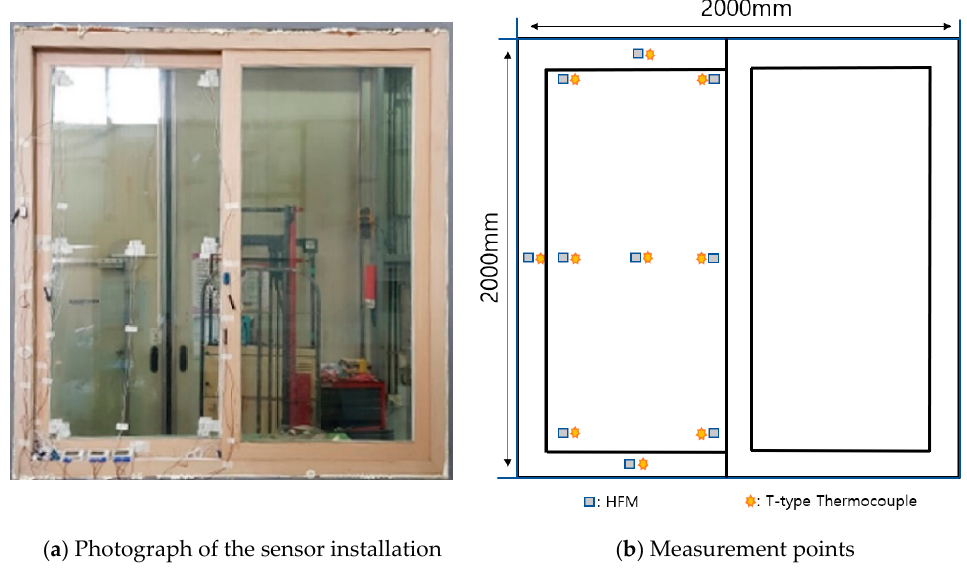
Figure 3. Window measurements using the heat flow meter (HFM) method. ( a ) Photograph of the sensor installation; ( b ) Measurement points.